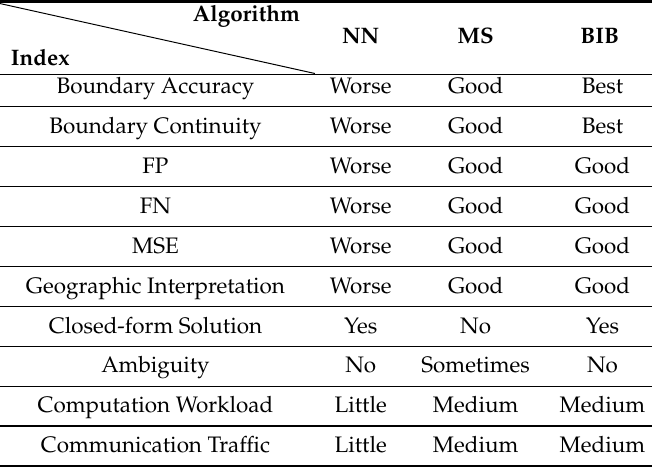
Table 4. Algorithm